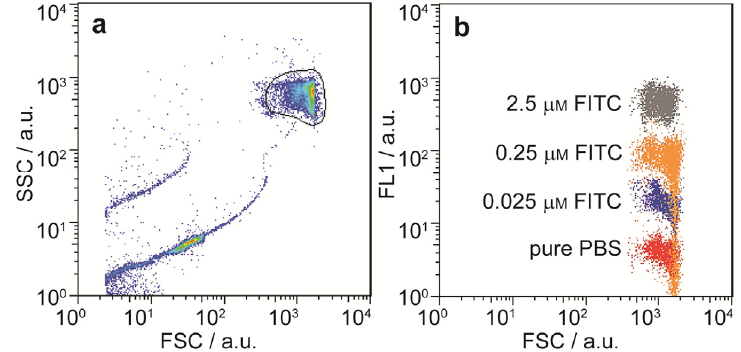
Figure 4. Flow cytometric analysis of w/o/w double emulsion droplets with varying FITC